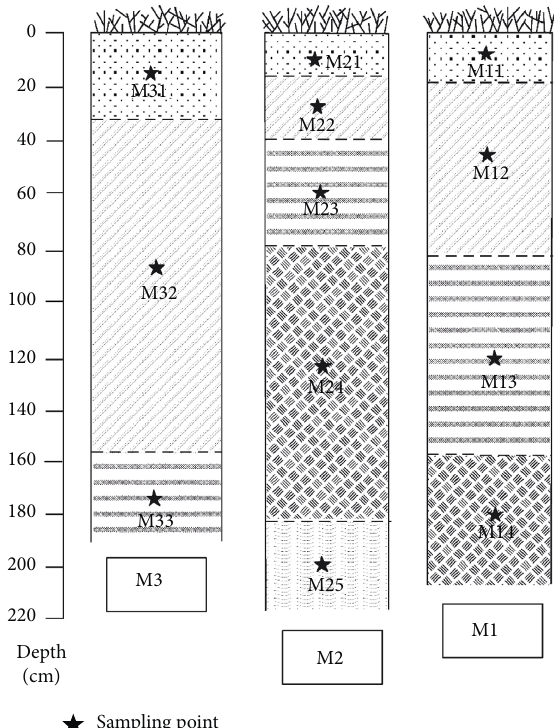
Figure 2: Morphological organization of the studied